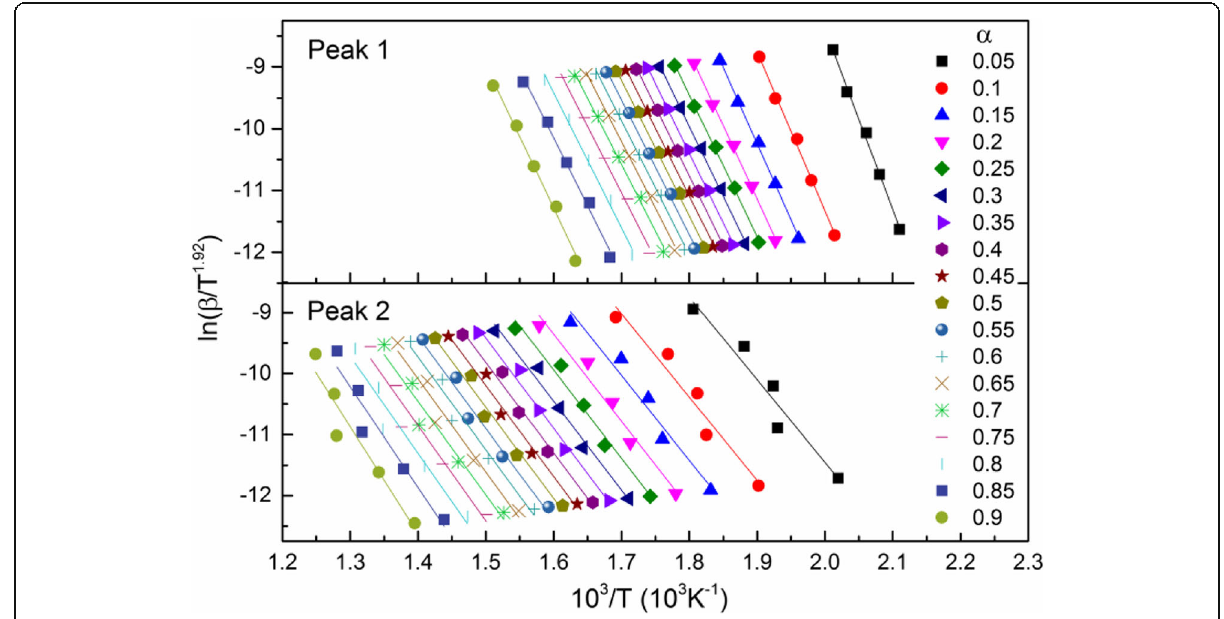
Fig. 6 Isoconversional plots of MKAS method for the first (peak 1, top) and second (peak 2, bottom) degradation